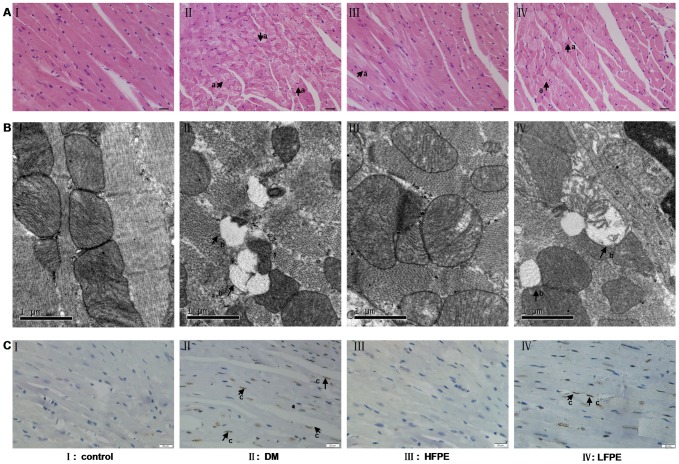
FPE ameliorated myocardial injury in experimental diabetic mice.A: Representative pictures of myocardial tissue sections stained with hematoxylin and eosin (magnification = 400×), n = 6 per group. Arrow a indicates perinuclear vacuolization, bar is 20 µm. B: Representative transmission electron micrographs of left ventricular specimens, n = 4 per group. Arrow b indicates swollen mitochondria. C: Representative pictures of the TUNEL assay, n = 4 per group, bar is 20 µm. HFPE: high dose, 200 mg/kg; LFPE: low dose, 100 mg/kg.